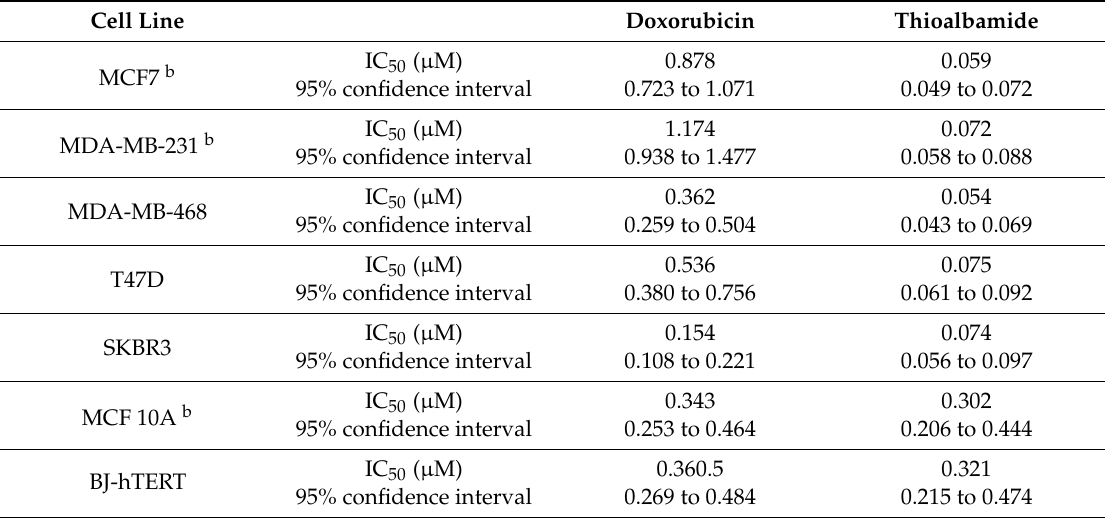
Table 1. Cytotoxic activity of thioalbamide in comparison to doxorubicin a